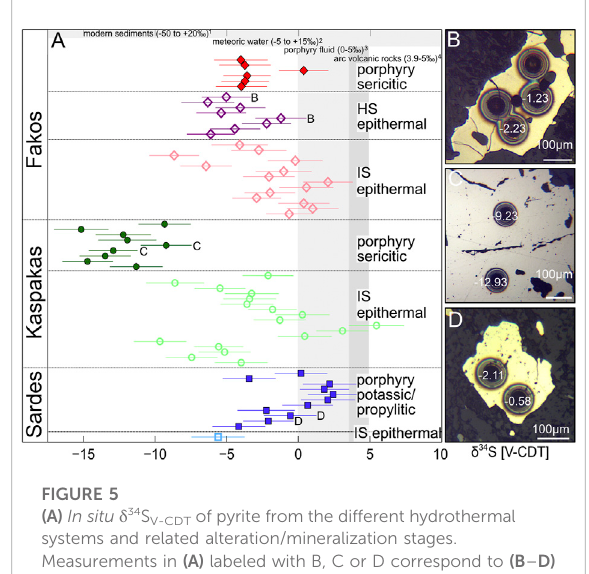
FIGURE 5 (A) In situ δ 34 S V-CDT of pyrite from the different hydrothermal systems and related alteration/mineralization stages. Measurements in (A) labeled with B, C or D correspond to (B – D) showingthe δ 34 S variations inindividual pyritegrainsfrom the three prospects. The data is available in the electronic annex (Supplementary Table S7). The grey boxes in (A) represent literaturedatafortheisotopicrangeSsources( 1 modernsediments (Seal, 2006); 2 meteoric water (Geyh et al., 2000); 3 porphyry fl uids (Hutchison et al., 2020); 4 arc volcanic rocks (Falkenberg et al., 2022, and references therein) Modern seawater at ~21 ‰ is not show in this fi gure (Rees et al., 1978; Tostevin et al.,